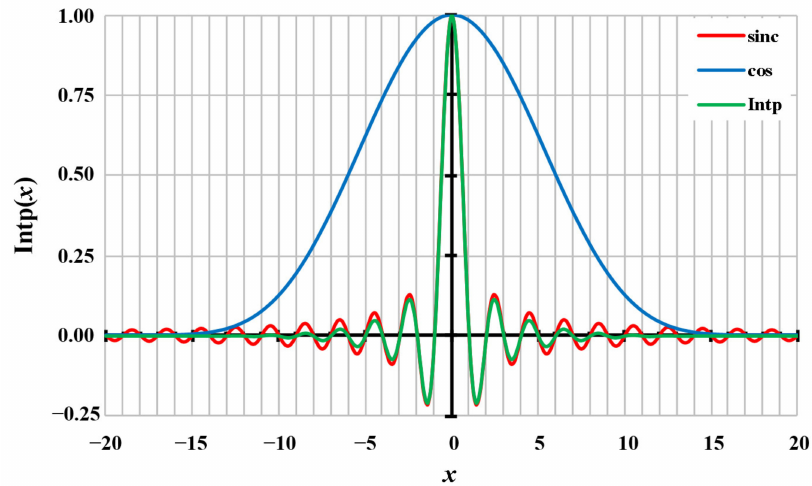
Figure 4. The composition of the interpolation kernel Intp(x) (green curve) can be seen by the pure sync function (red) and the modifying cos q function (blue curve) for N F = 40 and q =